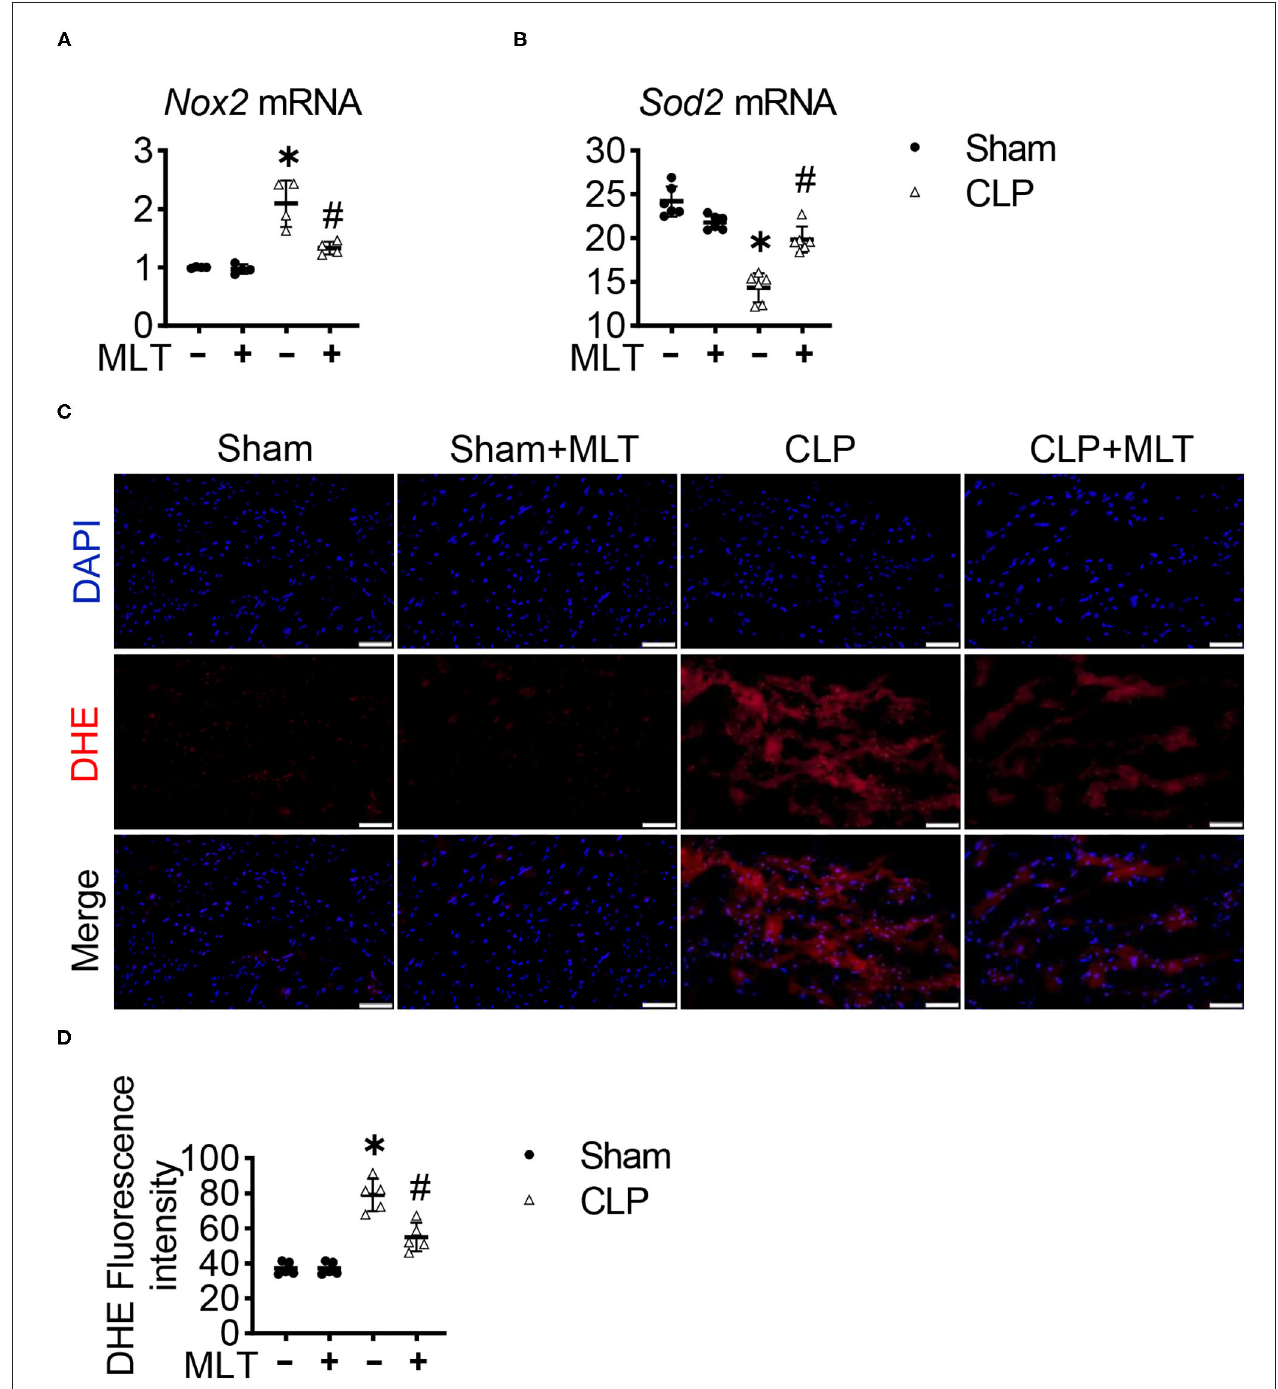
FIGURE 5 | Melatonin reduces reactive oxygen species (ROS) in CLP-induced mice. Nox2 (A) and Sod2 (B) mRNA levels are measured using RT-PCR. (C) Representative images of dihydroethidium (DHE) staining of the heart tissues (scale bar = 50 µ m). (D) The ROS production was quantified and presented as the mean fluorescence intensity. Values are presented as means ± SD, *vs. sham, p < 0.05; # vs. CLP, p < 0.05.